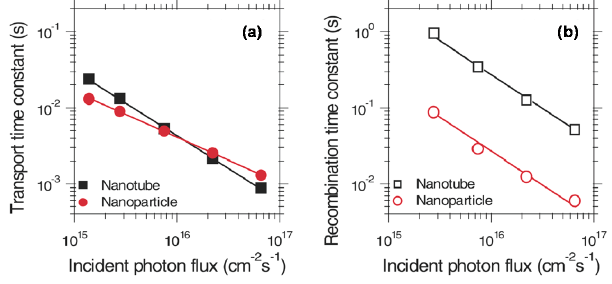
Figure 2. Comparison of ( a ) charge transport time; and ( b ) recombination time constants for NP- and NT-based dye-sensitised solar cells (DSCs) as a function of the incident photon flux for 680 nm laser illumination. Reprinted with permission from [21]. Copyright 2007 American Chemical Society.